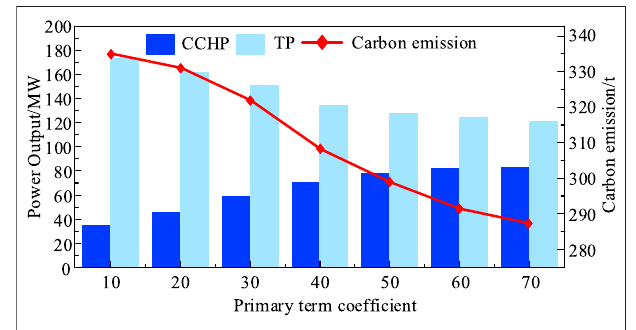
FIGURE 9 | Impact of the baseline value c of the CEUC on electricity purchasing and gas purchasing cost.